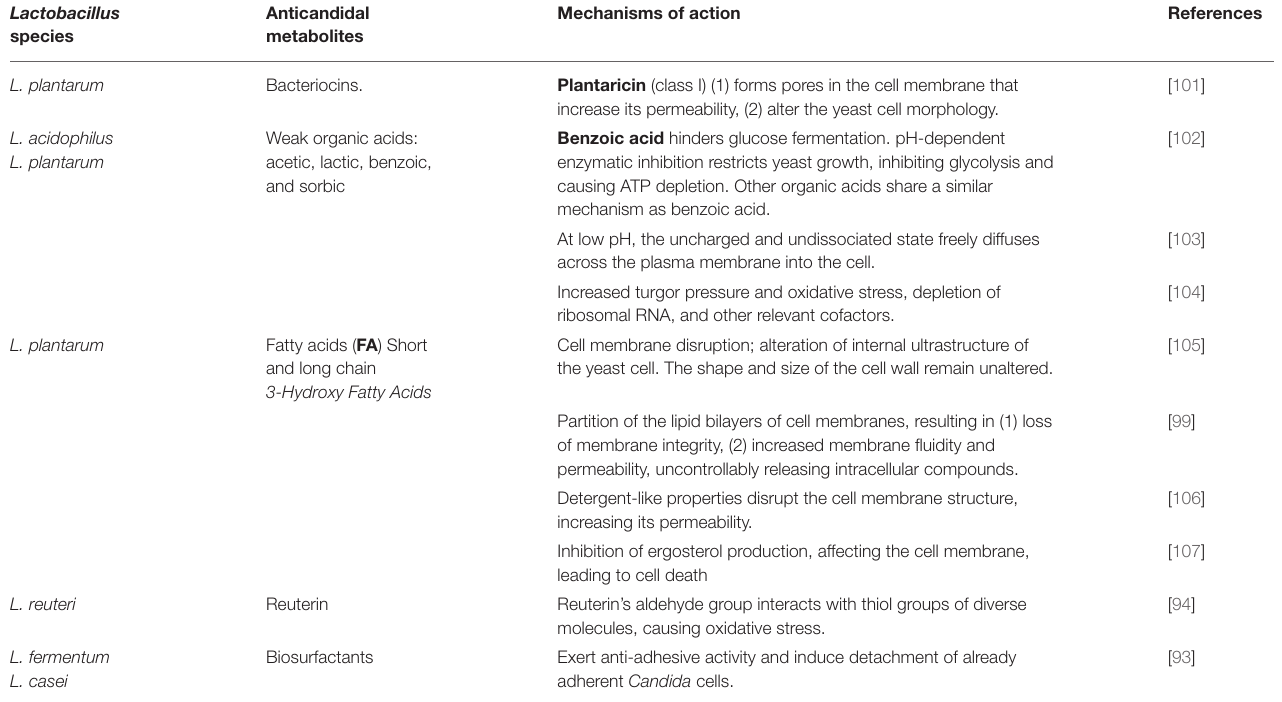
TABLE 1 | Known anticandidal mechanisms of action from lactobacilli metabolites. Lactobacillus